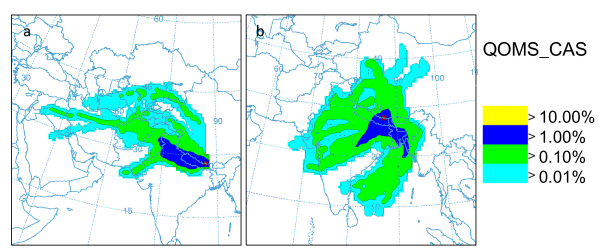
Fig. 5. Color-coded frequency plots of 5-day back trajectories by using HYSPLIT at QOMS_CAS (a) April 2012; and (b) July 2012. The red star indicates the location of QOMS_CAS site. To reflect the frequency plots clearly, different domains are used for the left and right